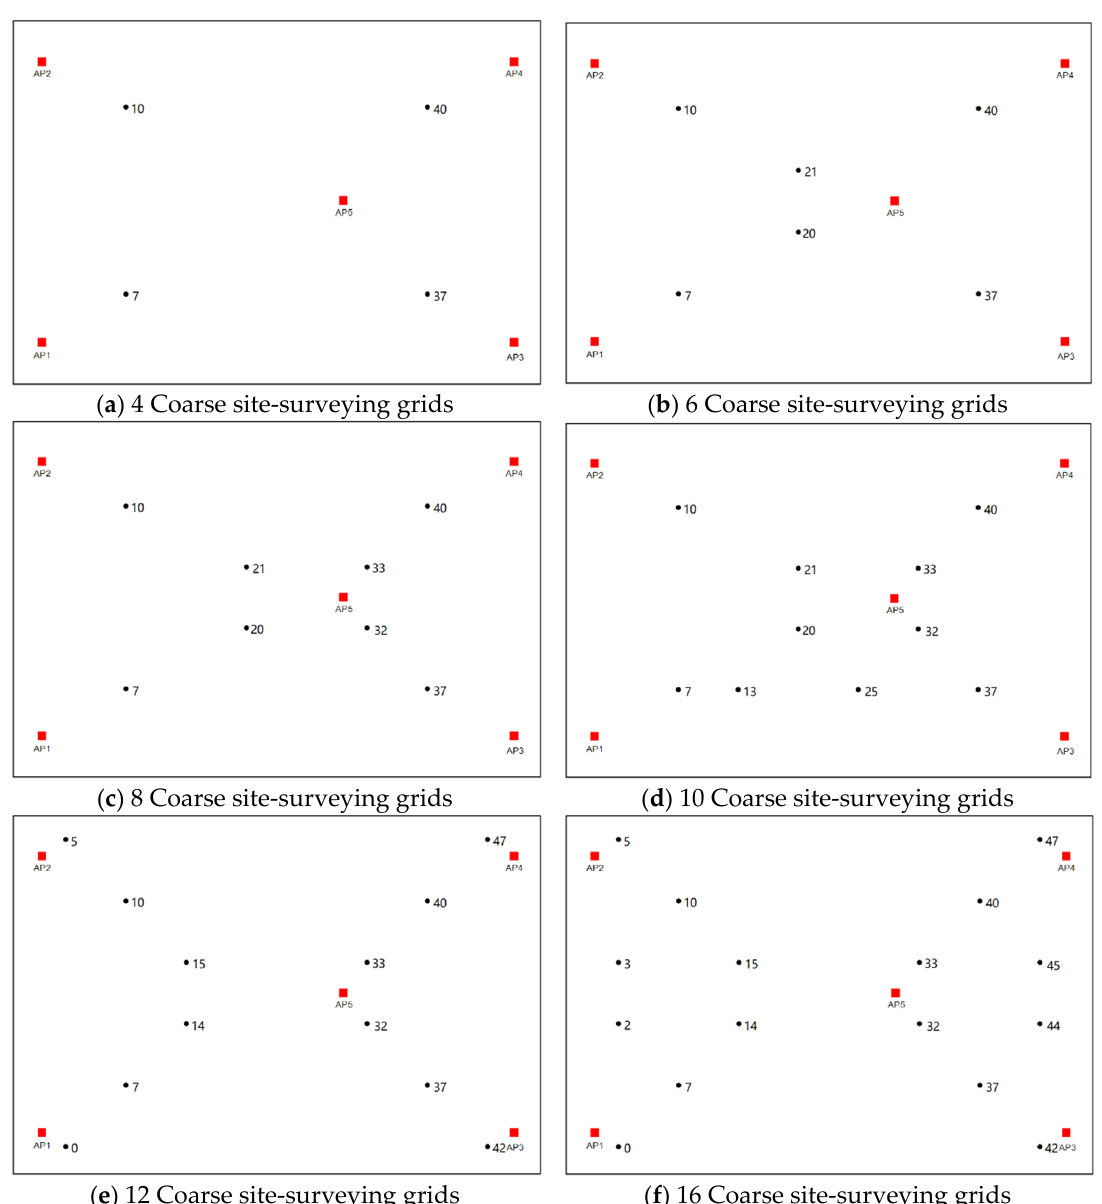
Figure 10. SS-RSS based on the fingerprints of increasing numbers of coarse site-surveying grids.